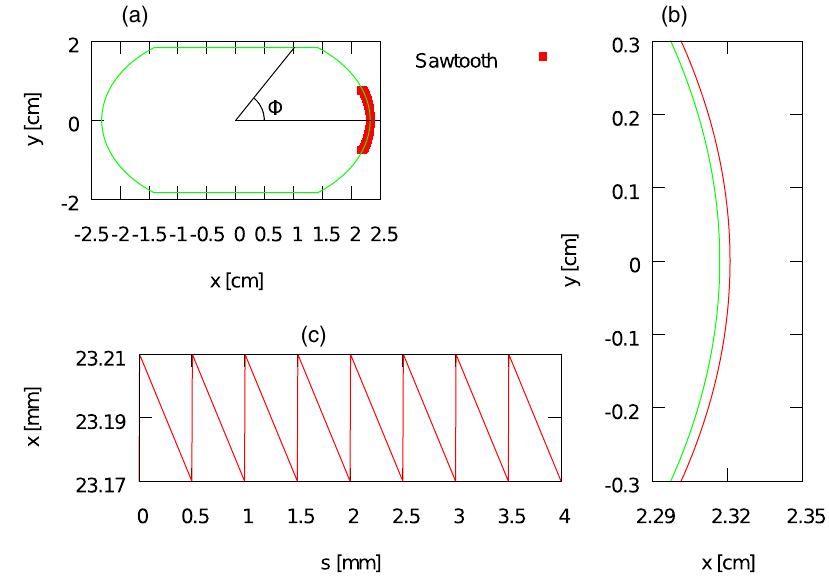
FIG. 3. S ynrad3 D model of the LHC beam-screen design. (a) xy cross section, (b) enlarged xy cross section, (c) xs cross section. If the beam is moving towards the positive s direction, it will see an inverted sawtooth; if it is moving towards negative s , it will see the correct form of the sawtooth.